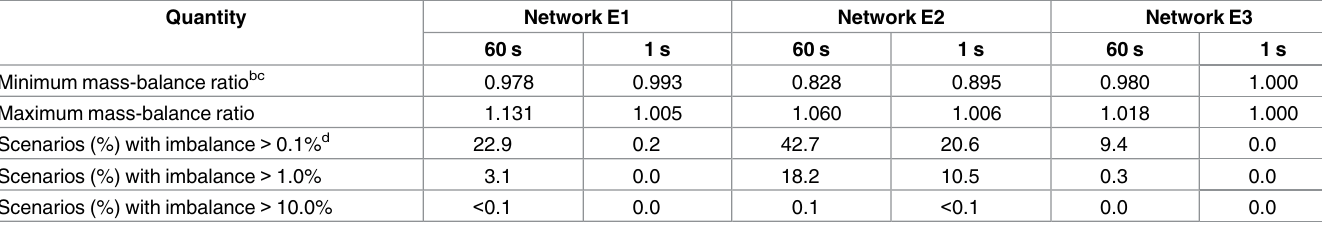
Scenarios (%) with imbalance > 10.0% a Results are for an ensemble, with a 168-h simulation and contaminant injected during the first hour. b Mass-balance ratio = ( R + T + P )/ I . The minimum ratio is the value for the scenario with the smallest mass-balance ratio. c Three deadend nodes in Network E3 have no flow at the time contaminant is injected. As a result, the contaminant is lost and the mass-balance ratio is zero. This value is not used as the minimum mass-balance ratio for the network. d Mass imbalance = |(mass-balance ratio—1)|.